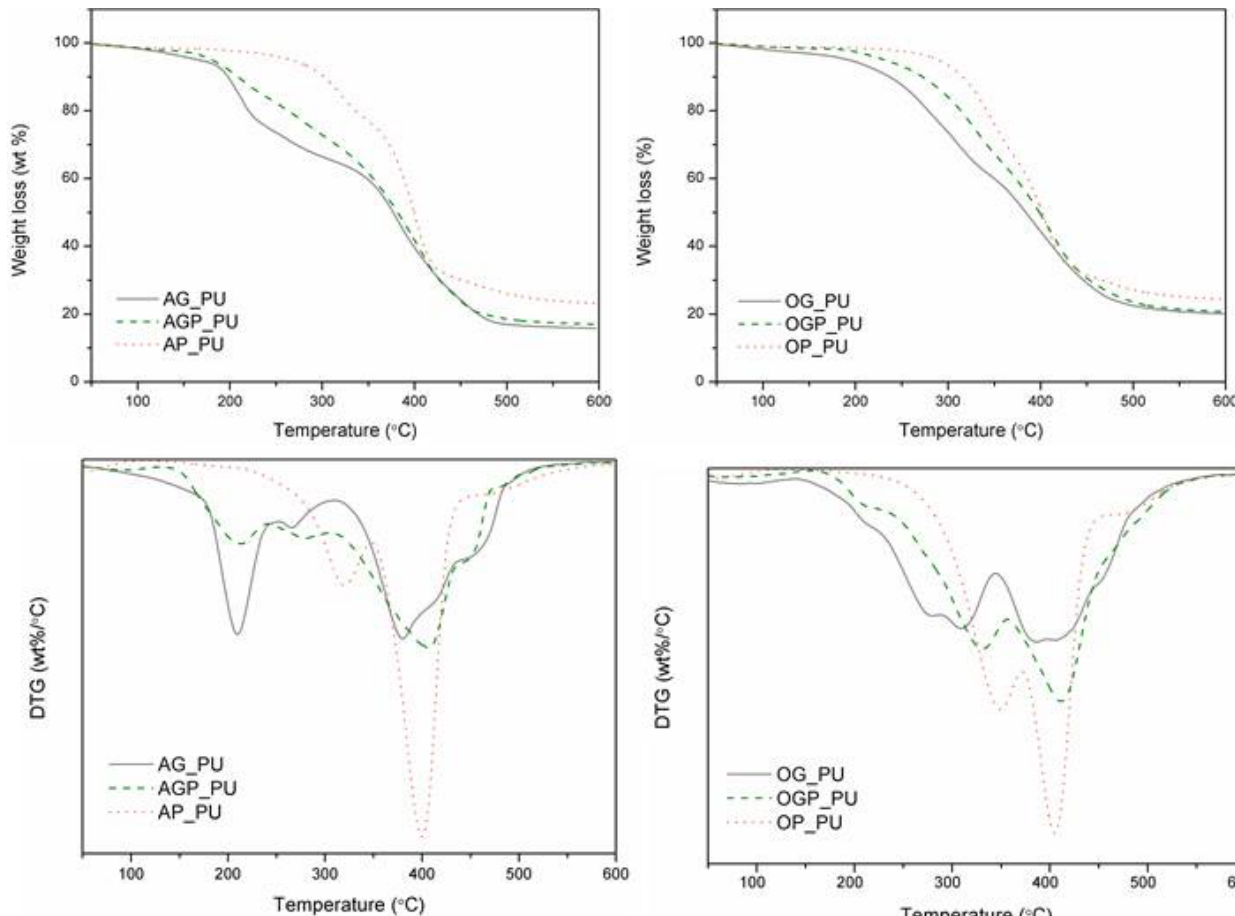
Figure 6. The TGA and DTG curves of the polyurethane resins . Table 5. Characteristics of thermal degradation of the polyurethane resins.